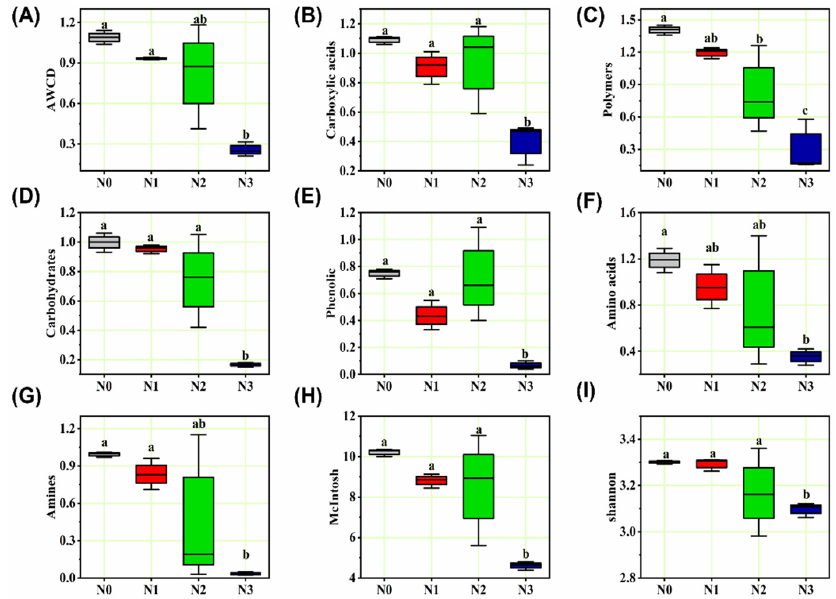
Figure 3. The average well-color development (( A ), AWCD) of all C sources, different C sources groups ( B – G ), and diversity indices ( H , I ) among treatments in cucumber soil. Different lowercase letters on the boxplot indicate significant differences ( p < 0.05) among treatments.